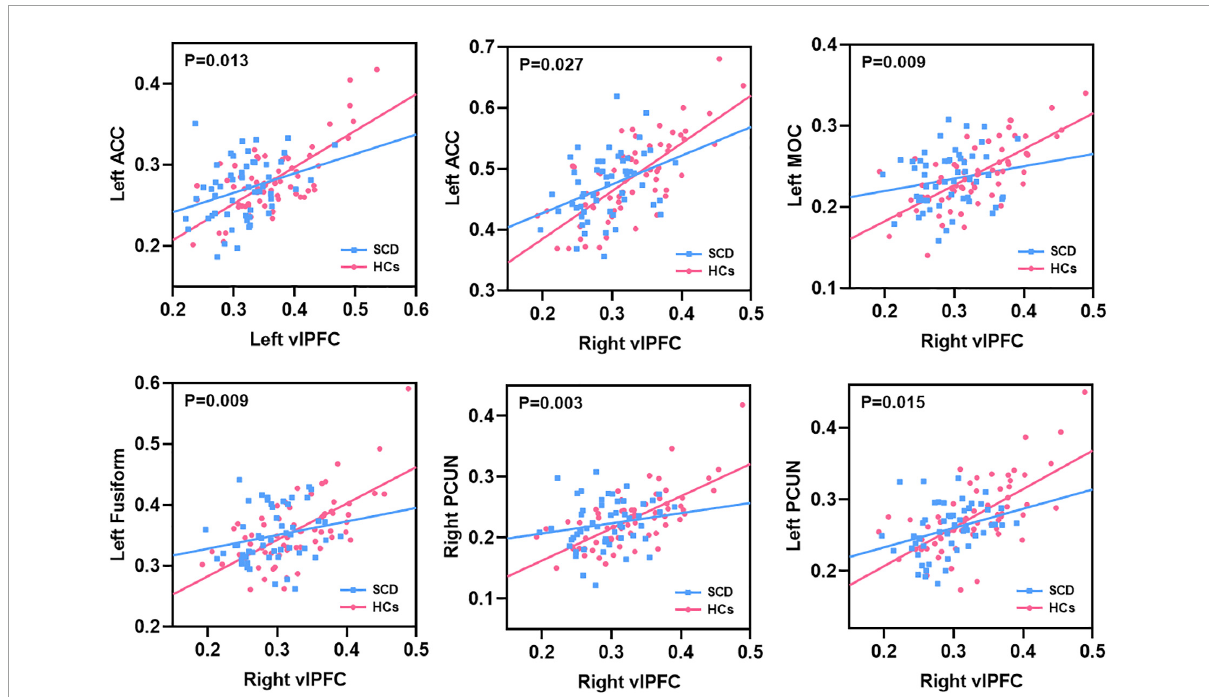
FIGURE6 The structural covariance differences between subjective cognitive decline (SCD) patients and healthy controls (HCs). Specific regions showed significant between-group differences with the bilateral